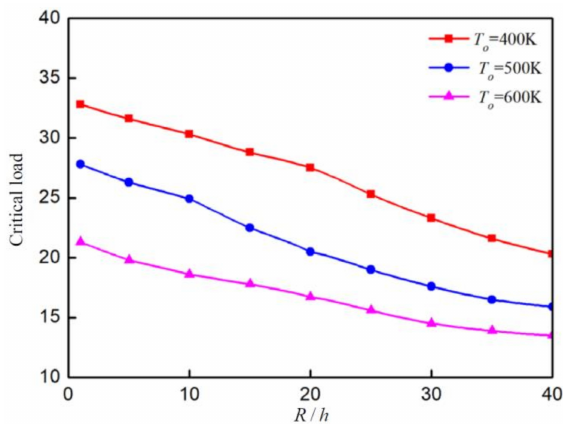
Figure 2. Critical in-plane load versus the ratio of radius to thickness R / h with different temperature fields.